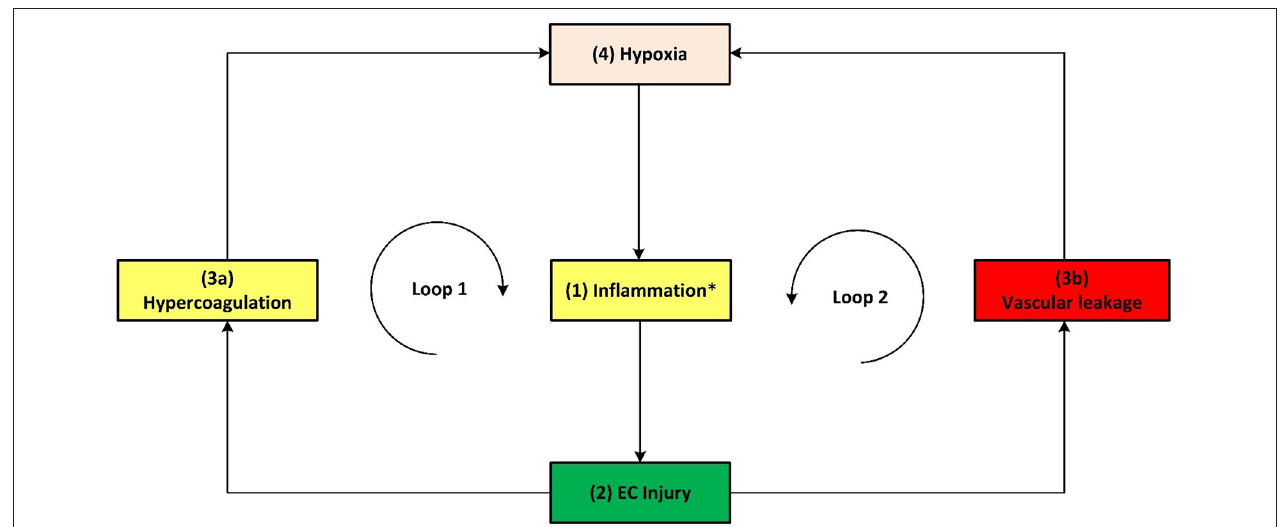
FIGURE 6 | Simplified schematic of the death spiral evident in some critical Covid-19 patients. The death spiral can be summarized as follows: Increased (1) inflammation at the lungs causes (2) EC injury, which can result in activation of the (3a) coagulation cascade and/or (3b) vascular leakage at the lungs, thereby causing (4) hypoxia which further increases inflammation, creating two closed positive feedback loops and causing severe Covid-19 through a death spiral. *As described in the text, this inflammation is initiated by various factors, primarily by a hyperimmune response to infection of SARS-CoV-2 (cytokine storm) but also other factors such as hyperinsulinaemia/hyperglycaemia or hypercholesterolaemia.